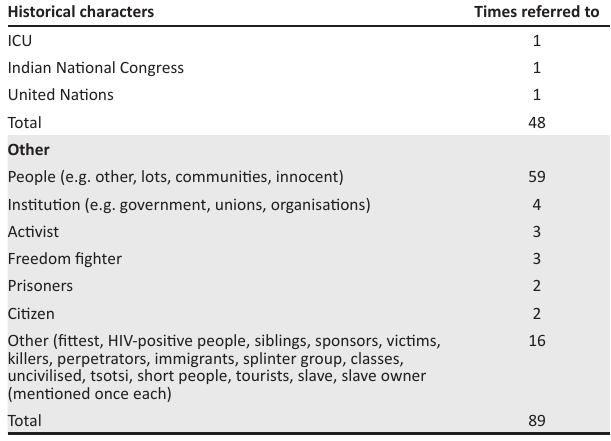
TABLE 1: Historical characters and times referred to. Historical characters Times referred to Race or ethnicity